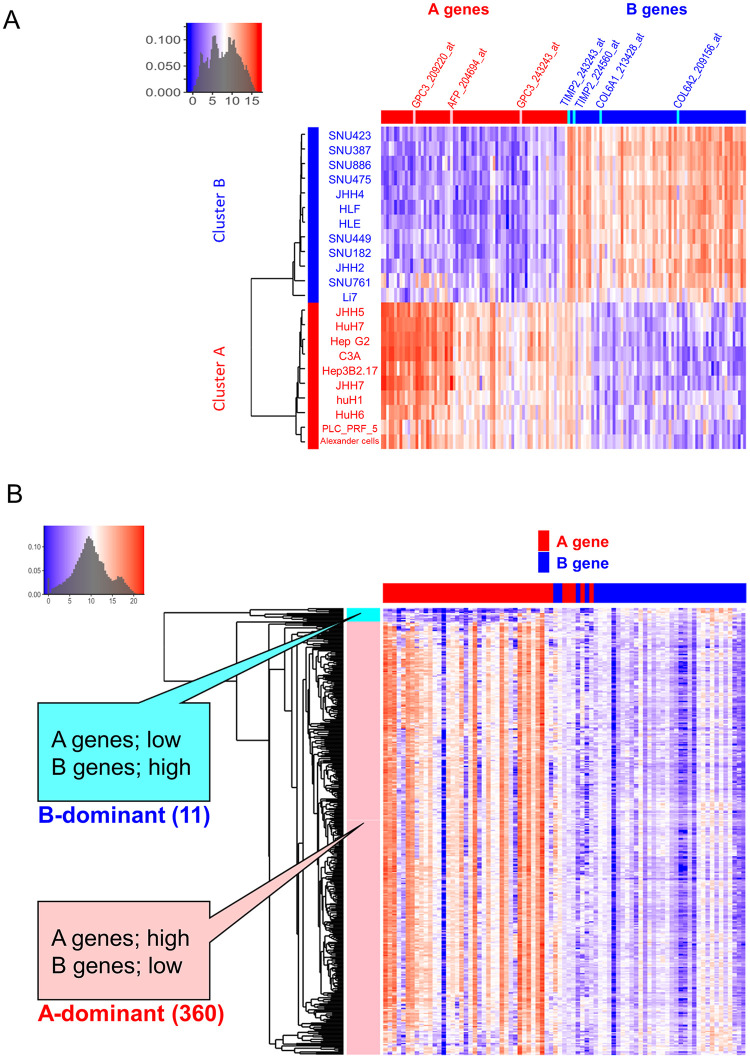
Heatmap visualization and hierarchical clustering of the selected differentially expressed genes.Heatmap showing the hierarchical clustering of (A) 22 liver cancer cell lines from the Cancer Cell Line Encyclopedia (CCLE) and (B) 371 hepatocellular carcinoma (HCC) tumor samples from the Cancer Genome Atlas (TCGA) based on their gene expression. Each row represents one sample (cell line or HCC), and each column represents the expression level of one gene.